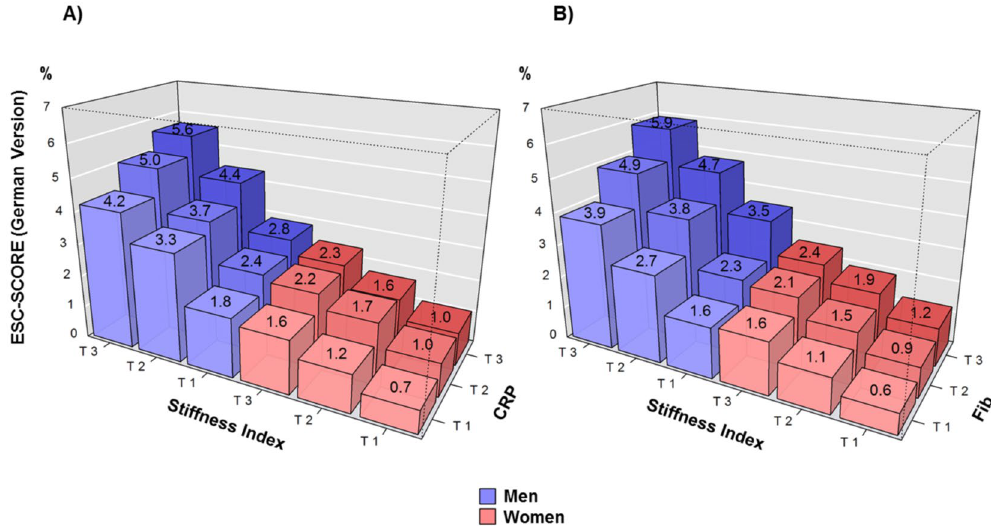
Figure 2. Ten-year Risk for Fatal MI or Stroke According to the German Version of the ESC-SCORE by Tertiles of Stiffness Index and ( A ) C-reactive Protein or ( B ) Fibrinogen . CRP stands for C-reactive protein and Fib for fibrinogen.